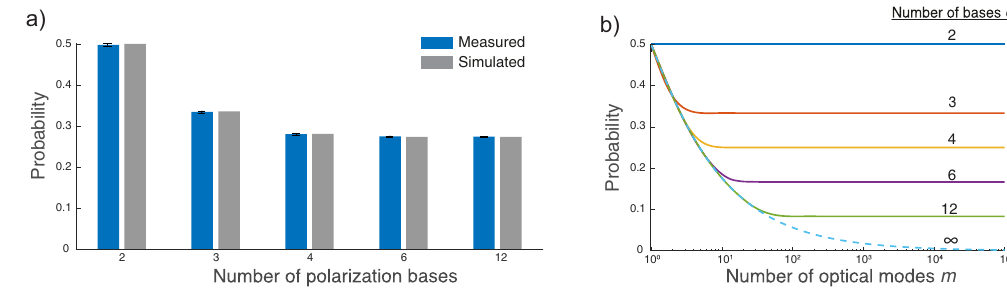
Fig. 4 Privacy of the input state for the computation. A nearly optimal attack is for Bob to measure all of Alice ’ s photons in a randomly chosen basis. The security of Alice ’ s input depends on the number d of polarization bases (keys) d she can choose from and also the number of input modes m . a Probability of Bob correctly guessing Alice ’ s input for m = 4, as key size is increased from d = 2 to d = 12. b Calculated probability of correctly guessing the input with respect to number of bases d (lines) and modes m . The blue dashed line shows the asymptotic behavior for an in fi nite key number. All lines are theoretical upper bounds (see “ Methods ” for